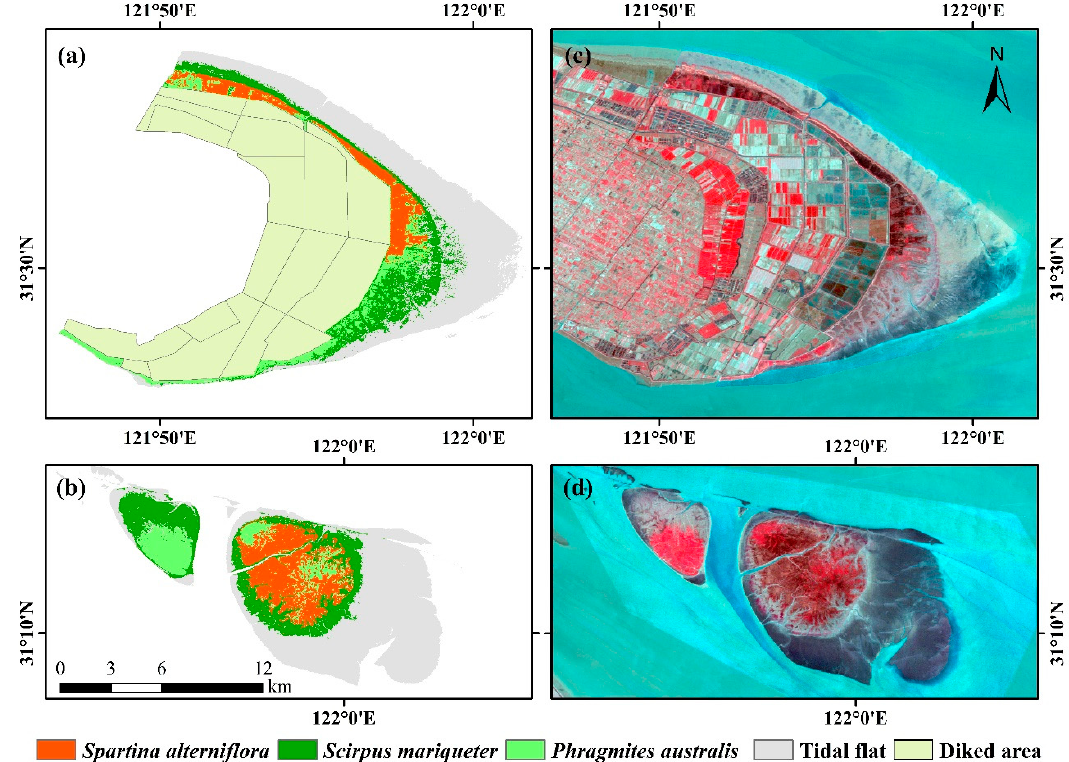
Figure 4. Distribution of Spartina alterniflora in ( a ) CMI and ( b ) JDSI; standard false color image of ( c ) CMI and ( d ) JDSI of Landsat TM image (Date: 2006.04.20; Path/Row: 118/38); water is not shown in (a) and (b).